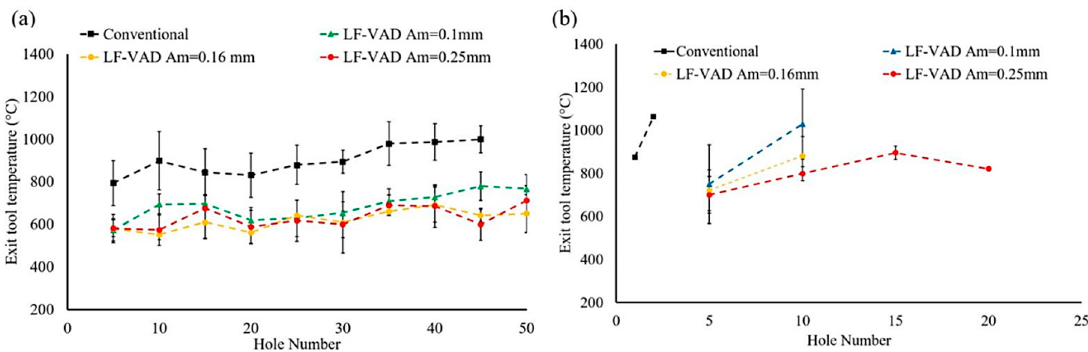
Figure 6. The effect of tool wear progress on the exit tool temperature at different vibration amplitude for N = 56.52 m/min: ( a ) f = 0.025 mm/rev and ( b ) f = 0.075 mm/rev.